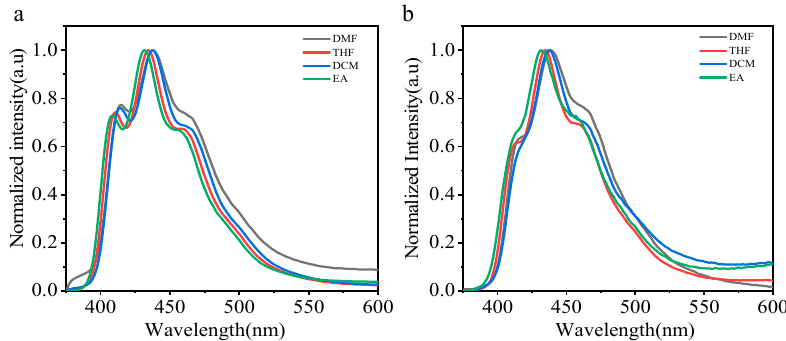
Figure 4. Fluorescence emission spectra of CZ-NI-O-PLA ( a ) and CZ-NI-S-PLA ( b ) in different polar solvents.